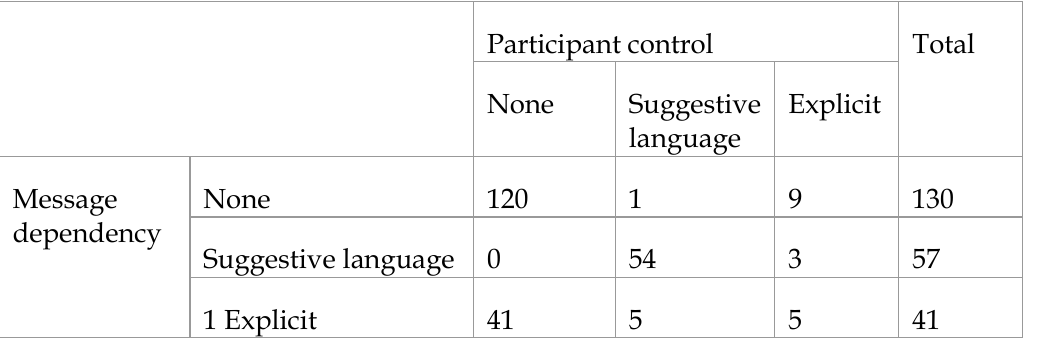
Table 6: Cross Tabulation of Suggested and Explicit Communication